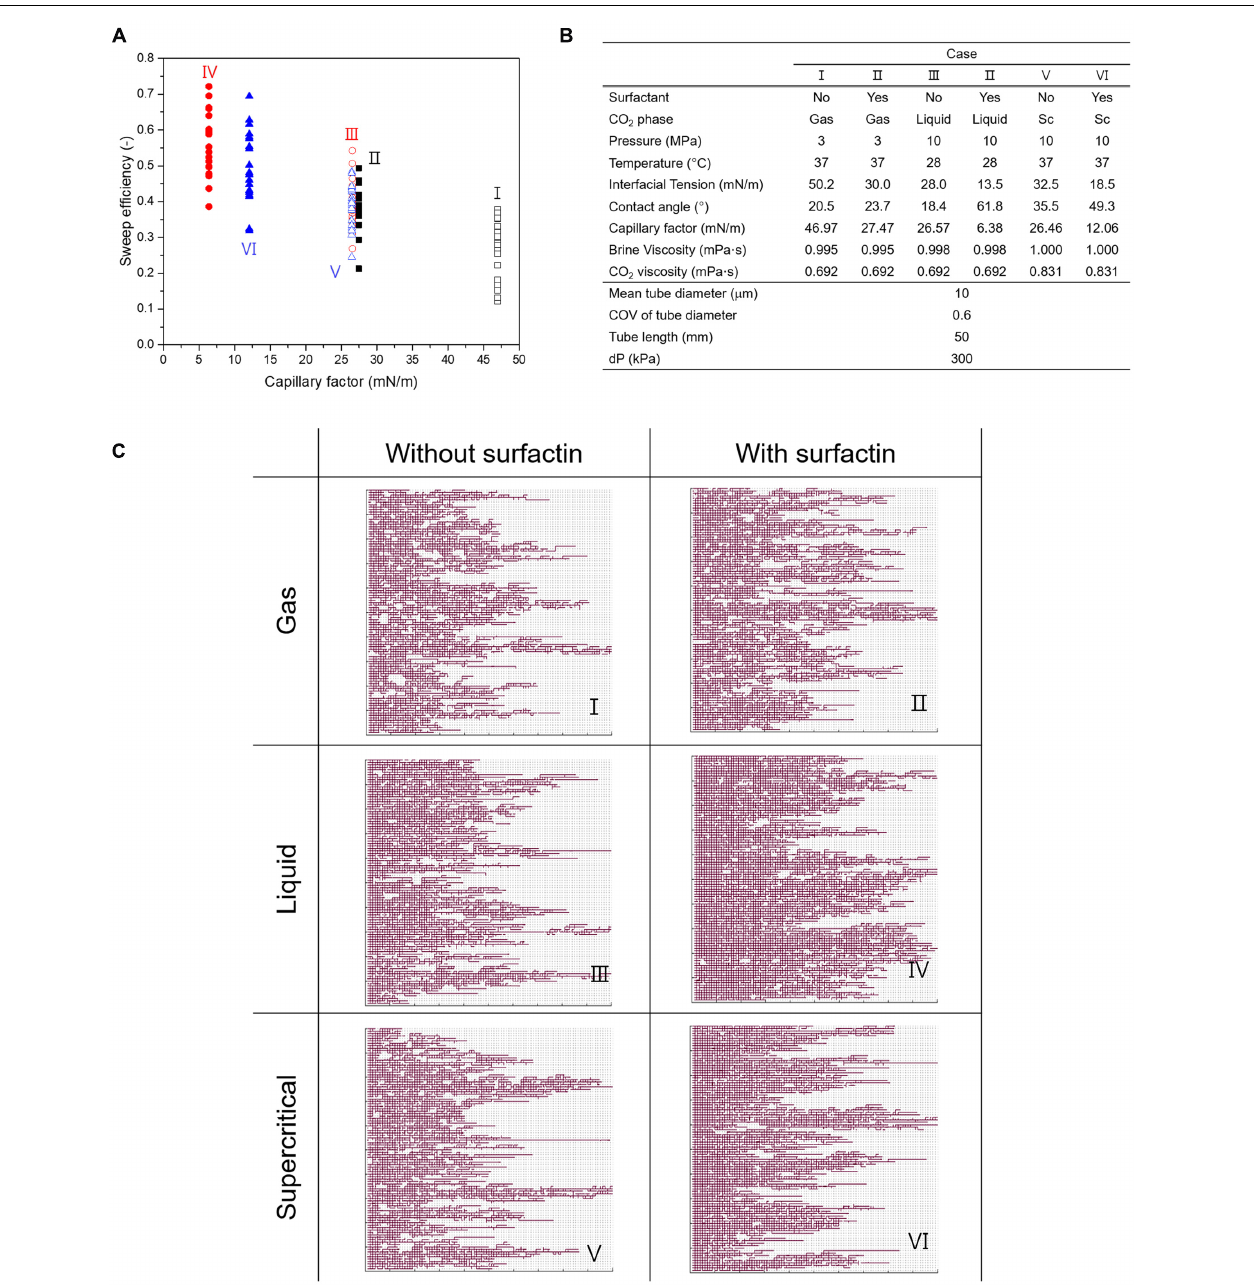
FIGURE 5 | The results of PNM simulations. (A) Variations in sweep efficiency for the different cases. (B) Input parameters for PNM simulations. (C) The invasion patterns of CO 2 in pore networks with different capillary factors affected by surfactin production. Cases I, III, and V represent the conditions without surfactin production, and Cases II, IV, and VI represents the conditions with surfactin production. Gray lines indicate the brine-saturated tubes in the pore networks and the red color shows the spatial distribution of CO 2 . It is noted that more CO 2 occupies each pore network when surfactin